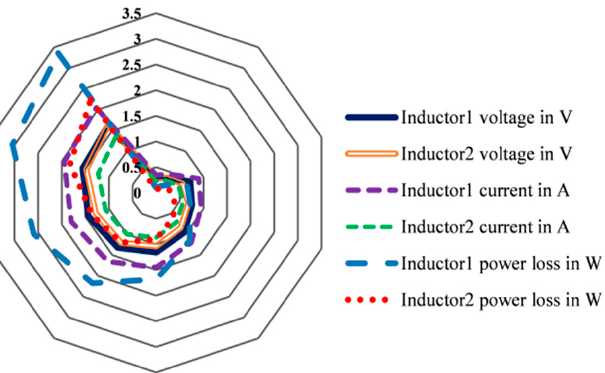
Figure 14. Inductor voltage, current and power loss comparison at f s = 5 kHz and D=50%. Table 14. Inductor voltage, current and power loss at f s = 10 kHz and D = 50%.